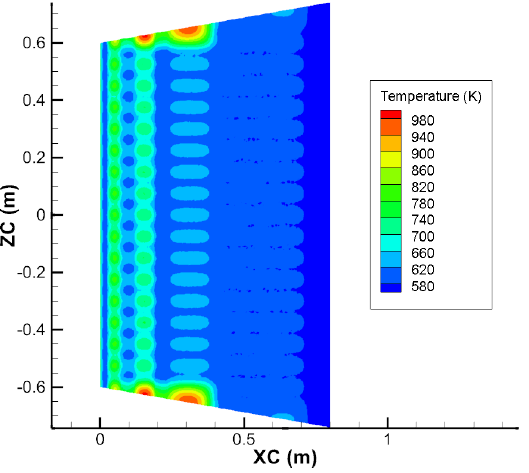
Figure 11. The temperature contour of XC-ZC cross section of the optimized model.